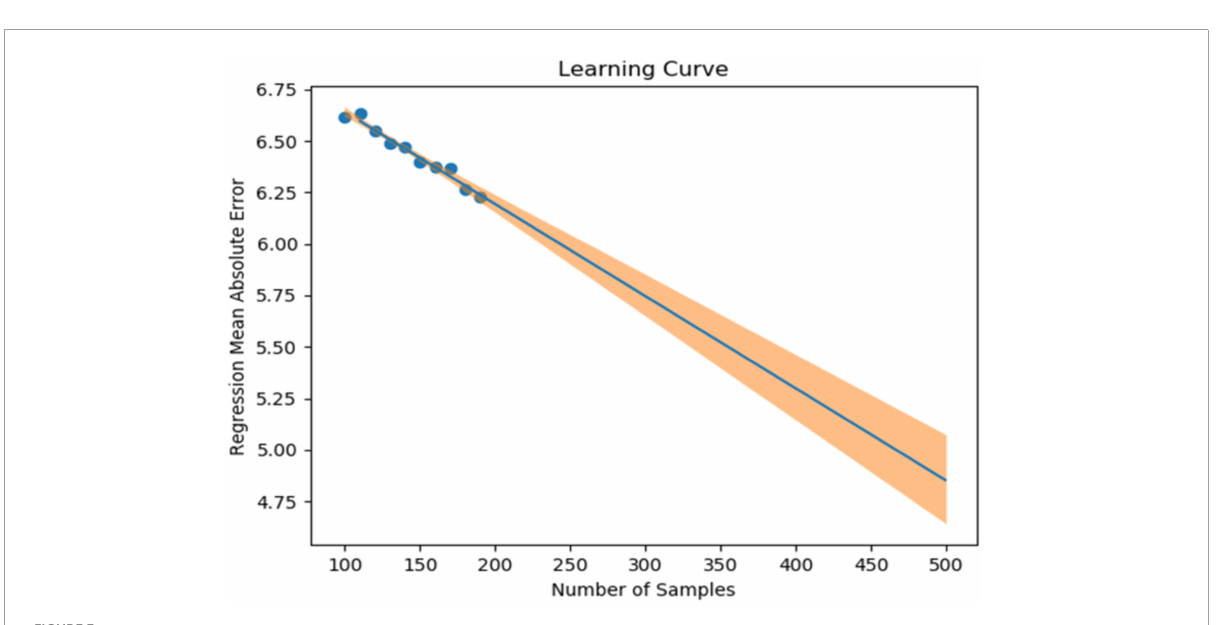
FIGURE3 Sample size (X-axis) and mean absolute error for the 17-item version of the Hamilton Depression Rating Scale (HAMD) actual values and estimated values (Y-axis).